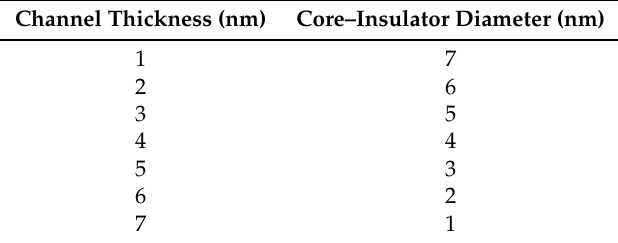
Table 2. Design parameter values for CIGAA.